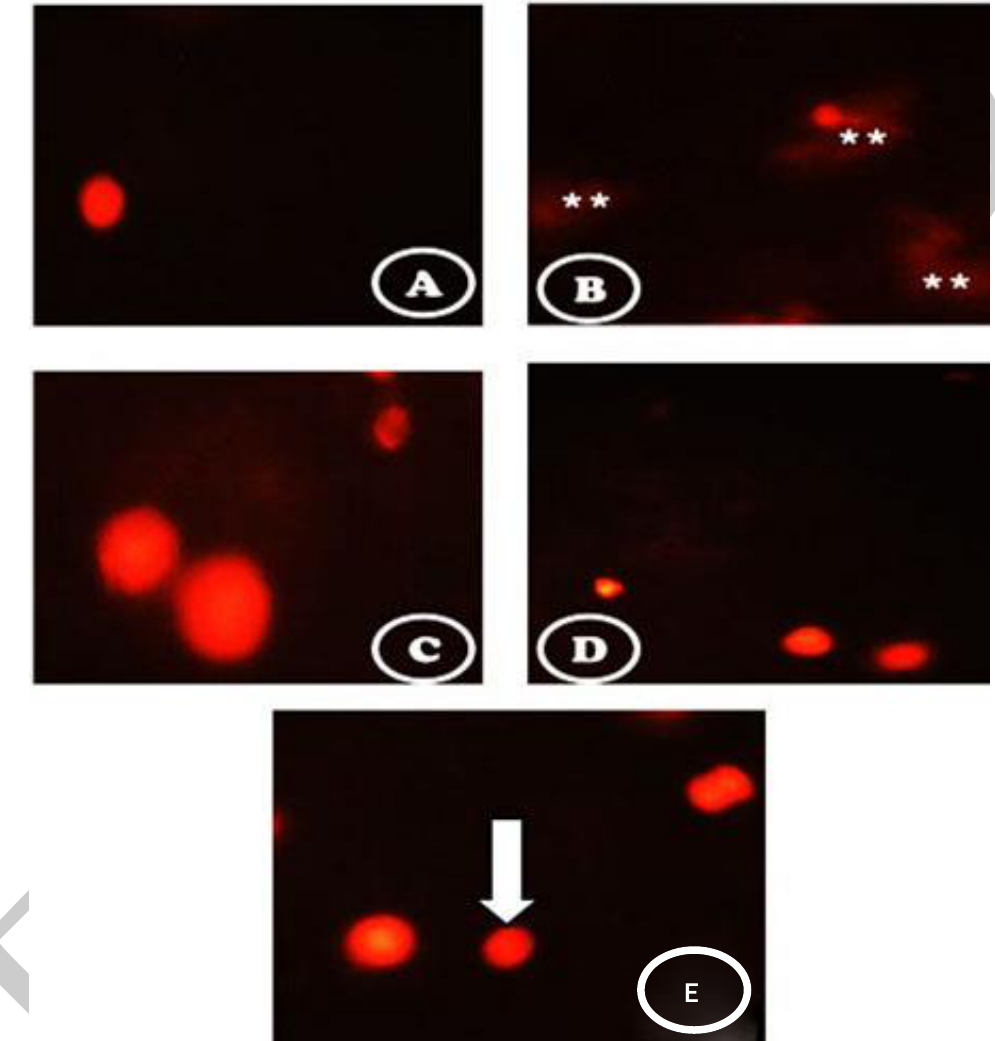
Figure 5. Comet images of cells derived from the pancreatic tissues ( A ) the control group showed intact nuclei and normal round cells without a hollow tail. ( B ) the STZ group showed a high degree of damage with the appearance of more than three apoptotic cells (white asterisks) with a large hollow tail and small head in the form of a comet shaped. ( C ) the STZ + stem cell group showed intact cells but with some apoptotic hollow areas. ( D ) the STZ + vit. D group contained intact cells with tails appearing as a hollow area. ( E ) the STZ + stem cell + vit. D group showed more intact cells with fewer damaged DNA strands and less damaged nuclei (white arrow).